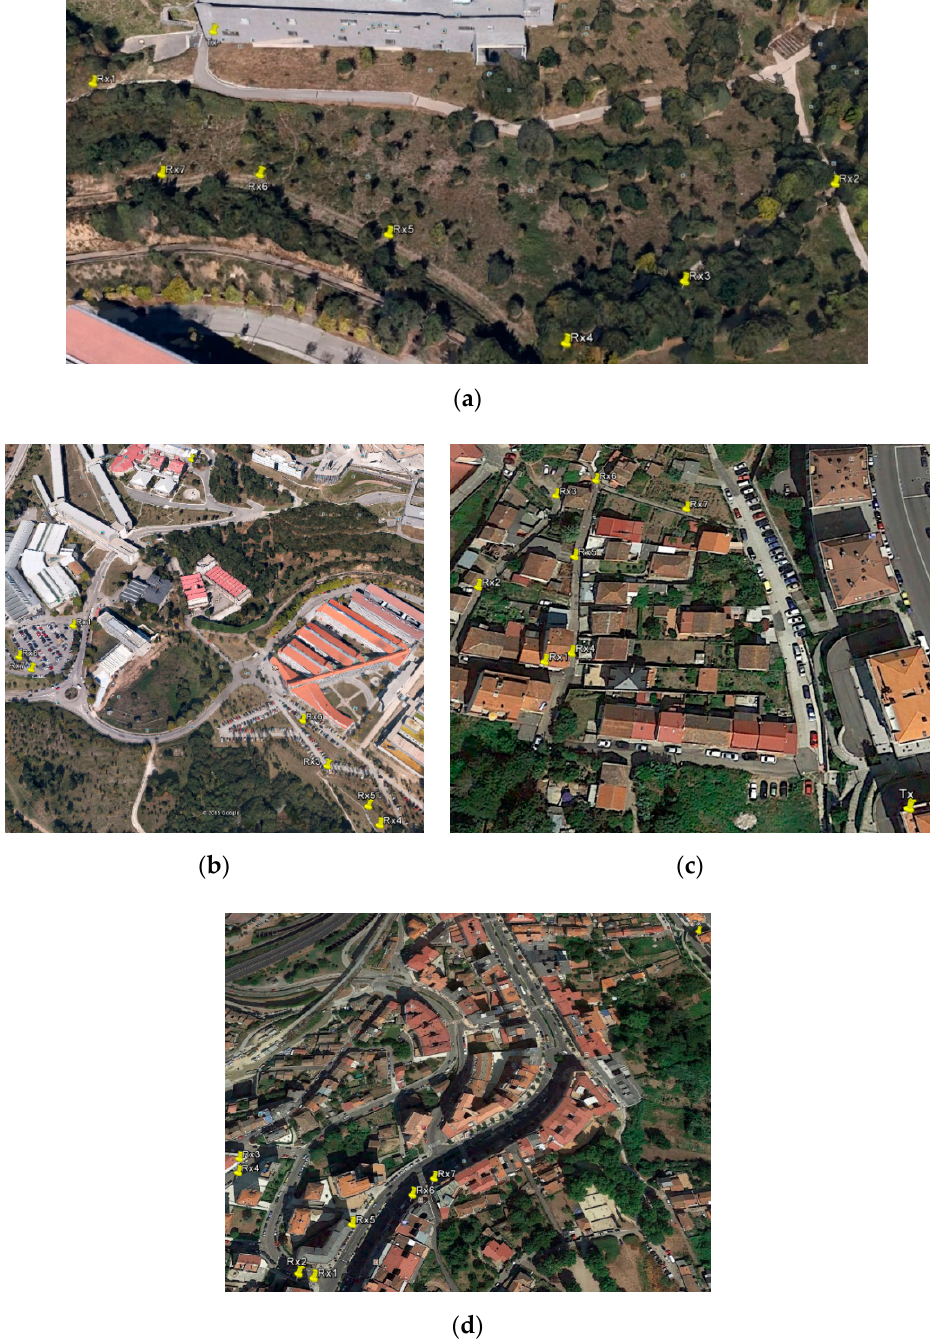
Figure 3. Location of Tx and Rx in the various environments: ( a ) wooded; ( b ) open; ( c ) suburban; ( d ) urban. Maps from Google, TerraMetrics.